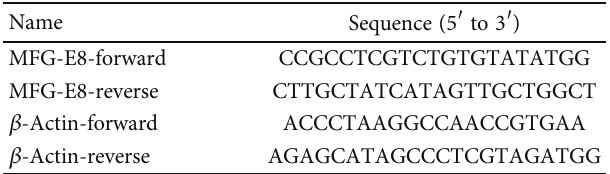
Table 1: Sequences of primers in the experiment. Name Sequence (5 ′ to 3 ′